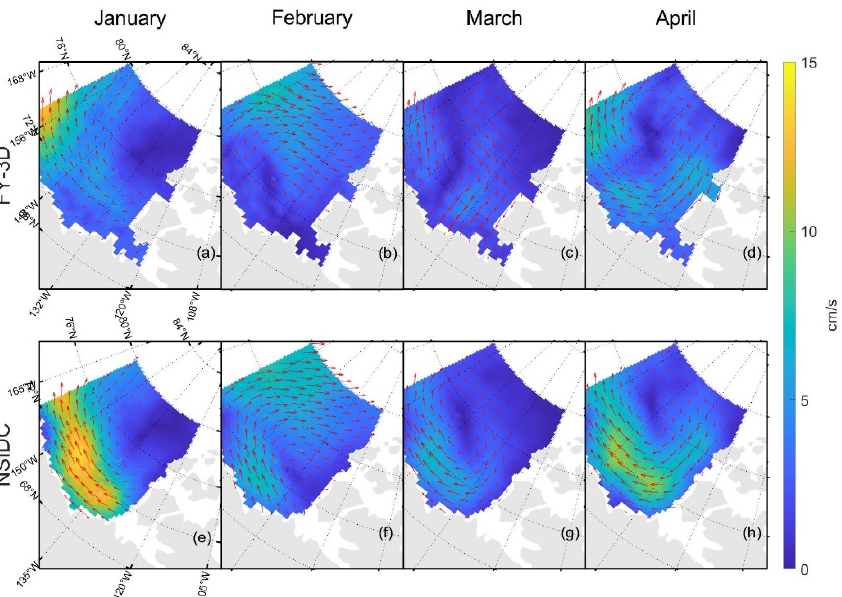
Figure 13. Schematic diagram of the monthly average product for the sea ice motion. Figure ( a )–( d ) show sea ice motion retrieved from FY ‐ 3D/MWRI T b data. Figure ( e )–( h ) show sea ice motion pro ‐ show sea ice motion retrieved from FY-3D/MWRI T b data. Figure ( e – h ) show sea ice motion provided vided by NSIDC. by